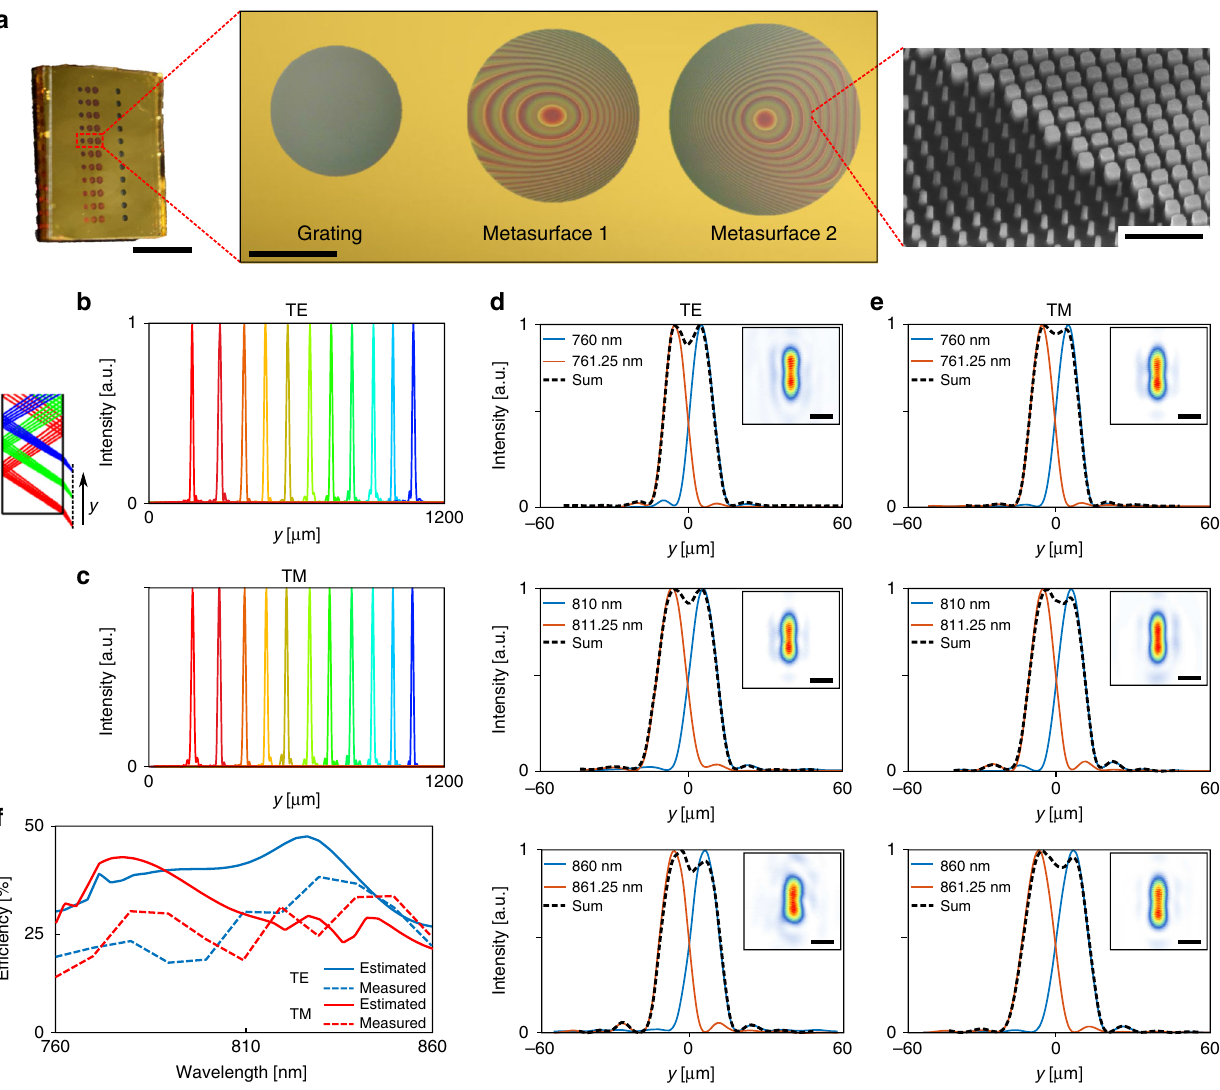
Fig. 4 Experimental characterization results. a An optical microscope image of the fabricated device and metasurfaces before deposition of the second gold layer. Inset shows a scanning electron micrograph of a portion of one of the two focusing metasurfaces (scale bars from left to right: 10 mm, 500 μ m, and 1 μ m). b , c One-dimensional focal spot pro fi les measured for several wavelengths in the bandwidth along the y -direction (as indicated in the inset) for TE and TM polarizations. The wavelengths start at 760 nm (blue curve) and increase at 10-nm steps up to 860 nm (red curve). d , e Measured intensity distributions for two input wavelengths that are 1.25 nm apart for TE and TM polarizations. The measurements were carried out at the center and at the two ends of the wavelength range for both polarizations. The insets show the corresponding 2-dimensional intensity pro fi les, demonstrating two resolvable peaks (scale bars: 10 μ m). f Calculated and measured absolute focusing ef fi ciencies of the spectrometer for TE and TM polarizations. Both polarizations have average measured ef fi ciencies of